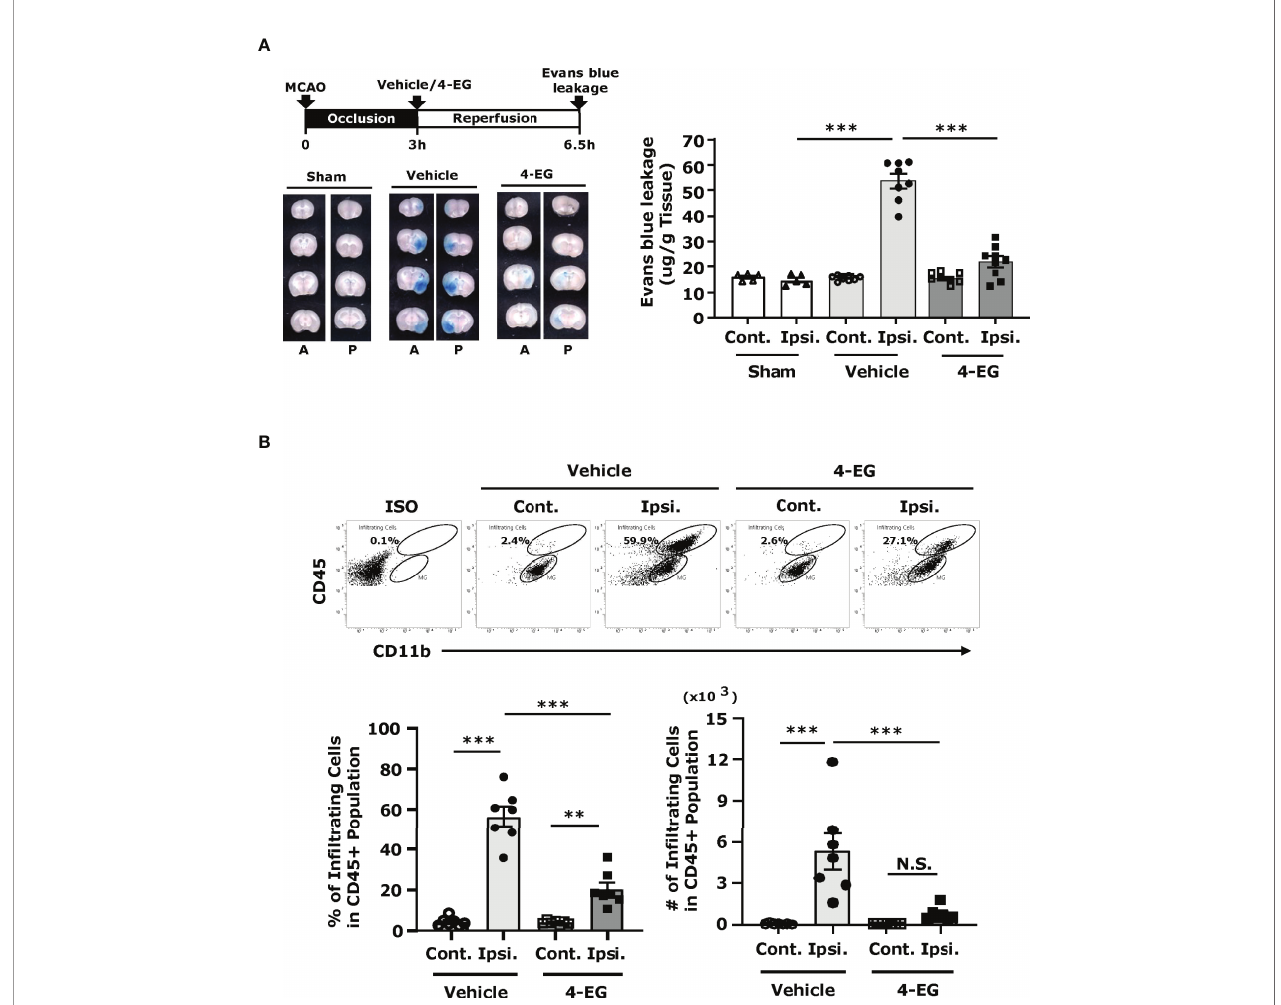
FIGURE 3 | 4-EG alleviates BBB disruption and represses peripheral immune cell in fi ltration of the CNS in ischemic stroke. (A) C57BL/6 male mice were subjected to sham or 3 h MCAO followed by vehicle or 4-EG administration. At 2.5 h post-reperfusion, mice were i.v.-administered Evans blue. 1 h after Evans blue injection, ischemic brains were harvested and sectioned. The representative brain images of sham, and vehicle- and 4-EG-treated MCAO mice are shown (A, anterior surface; P, posterior surface), and the Evans blue extravasation in the contralateral (Cont.) and ipsilateral (Ipsi.) hemispheres of sham (n=5), and vehicle- and 4-EG-treated MCAO mice (n=8/group) was determined. *** p<0.001 by two-way ANOVA. (B) C57BL/6 male mice subjected to 40 min MCAO were i.v. administered vehicle or 4- EG (100 mg/kg) at 2 h post-reperfusion. At 48 h post-injury, the ischemic brains harvested from vehicle- and 4-EG-treated MCAO mice were separated into the contralateral and ipsilateral hemispheres followed by mononuclear cell isolation (n=7/group). The isolated mononuclear cells were stained with antibodies against CD45 and CD11b and then analyzed by fl ow cytometry analysis. Isotype controls (Iso) were used as a negative control to determine CD45 int CD11b + MG and CD45 hi CD11b + in fi ltrating immune cells. The percentage and number of CD45 hi CD11b + in fi ltrating cells were then determined. **p < 0.01, *** p < 0.001 , N.S., no signi fi cant differences by two-way